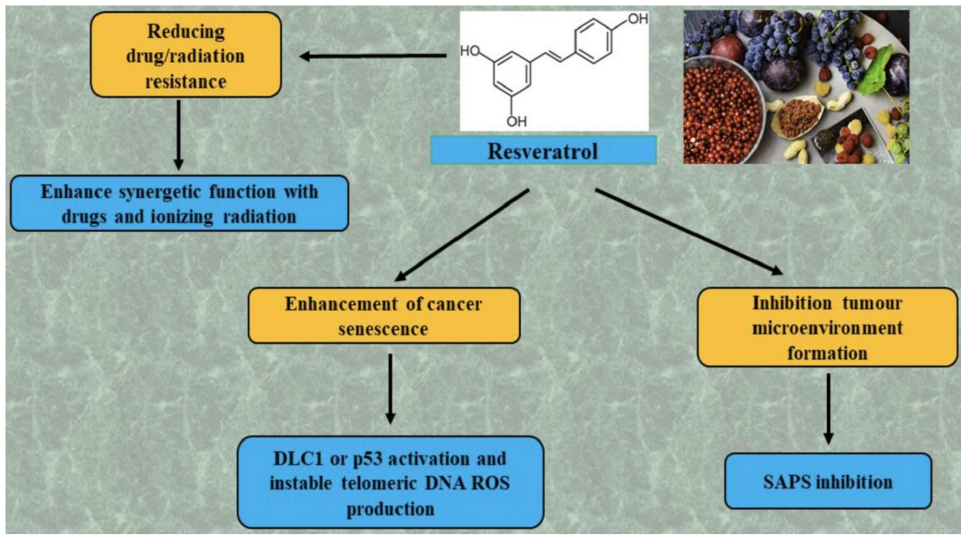
Figure 3. Potential anti-tumor effects of resveratrol. SASP, senescence-associated secretory phenotype; DLC1, deleted in liver cancer1; and ROS, reactive oxygen